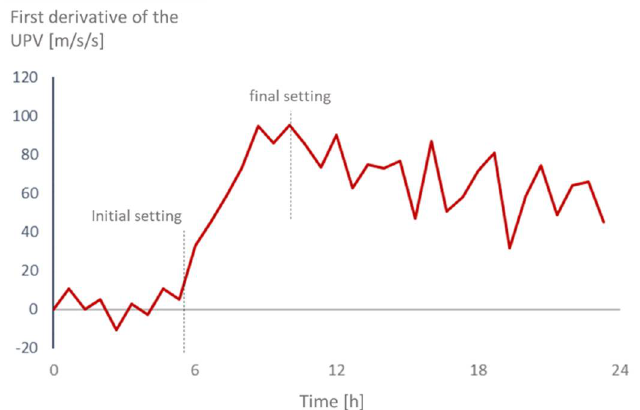
Figure 2. Determining the initial and final setting point based on the rate of the UPV (REF0.3). In order to improve the visualization of the graph, values are averaged over 30 min. Table 2. Average values and standard deviation of the initial and final setting time determined by the Vicat test and UPV (n = 2).